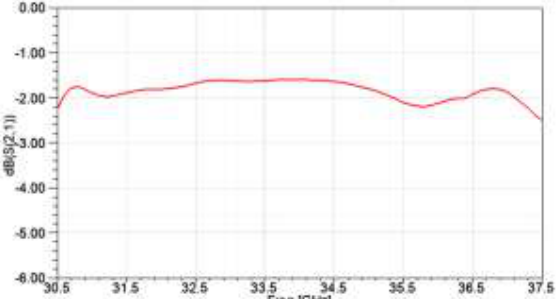
Figure 11: Simulated SPC Insertion Loss in dB, in the operating